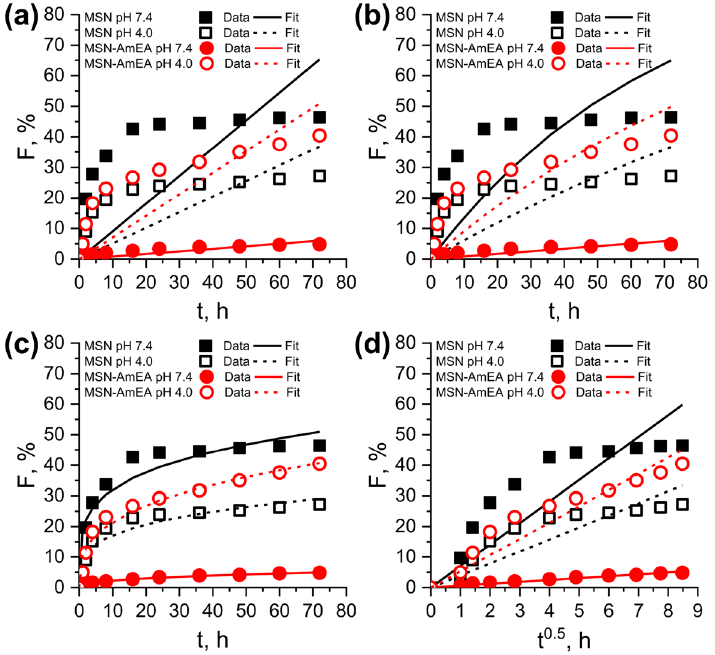
Figure 6. Non-linear fitting graph of quercetin release data from nanoparticles at pH 7.4 and 4.0 with the ( a ) Zero-order, ( b ) First-order, ( c ) Ritger–Peppas, and ( d ) Higuchi kinetic release models.